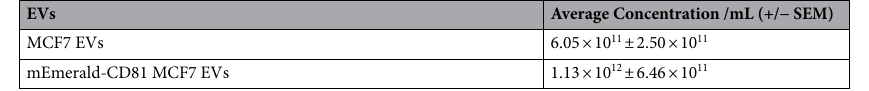
Table 1. Average EV concentration of MCF7 and mEmerald-CD81 MCF7 EV preparations. The table shows the average concentration in particles/mL quantified by NTA. N = 5 (biological), error bars =